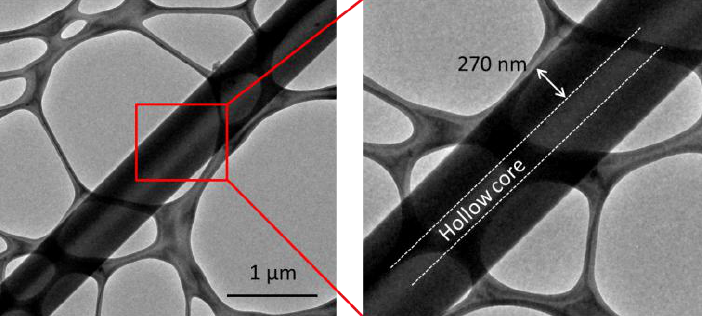
Figure 1. TEM image of electrospun CNFs, fabricated through accelerated stabilization of electrospun PAN nanofibers, at thermal stabilization temperatures of 294